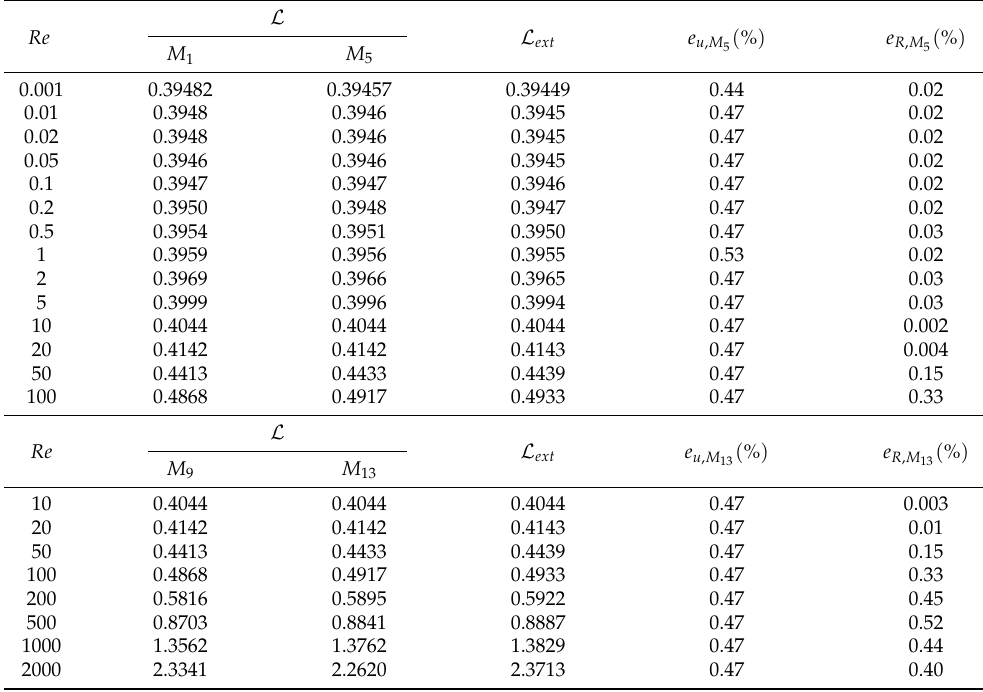
Table A1. Mesh accuracy tests and development lengths for AR =